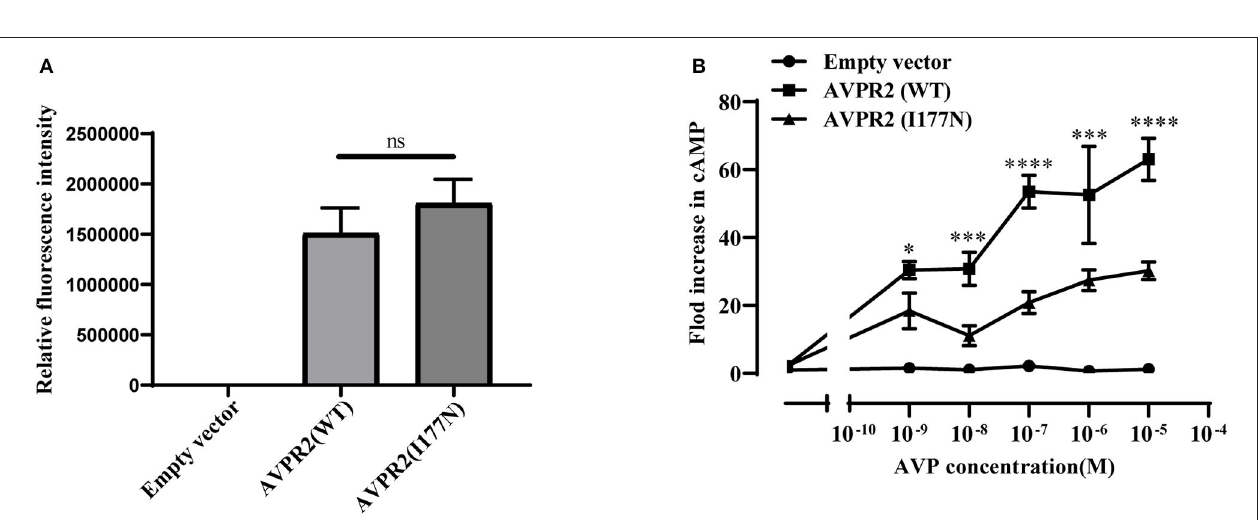
FIGURE 4 | (A) Relative fluorescence intensity of Flag-tagged AVPR2. Data were expressed as mean ± SEM, ns means no significant difference. (B) AVP-induced cAMP accumulation mediated by the wild-type AVPR2 (AVPR2-WT), mutant AVPR2(AVPR2-I177N) and empty vector. Data were expressed as mean ± SEM, * P < 0.05, *** P < 0.001, **** P <